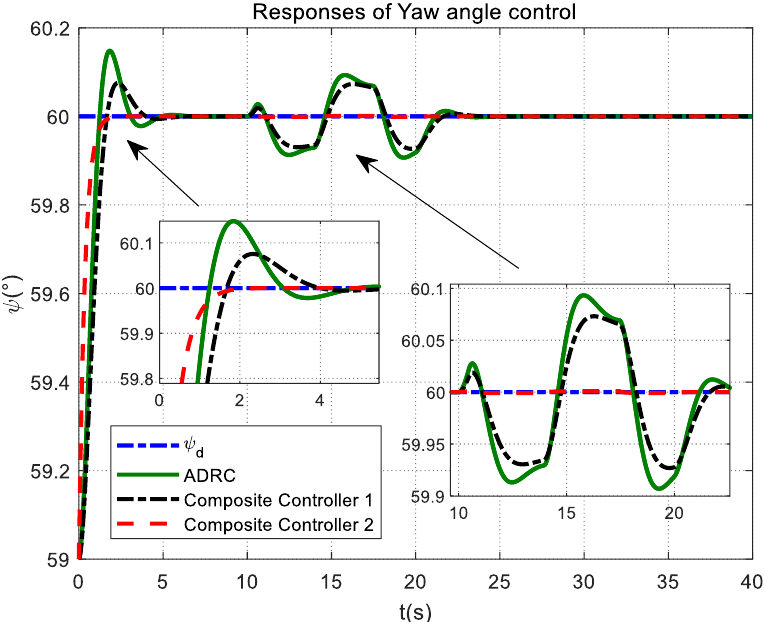
Figure 20. Responses of Yaw angle control for QUAV under actuator time-varying fault and disturbance condition.